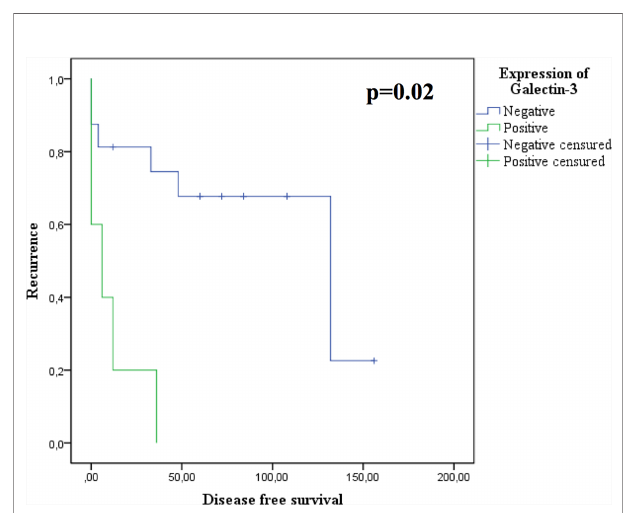
FIGURE 2 | Disease free survival according to galectin-3 expression. Kaplan- Meier